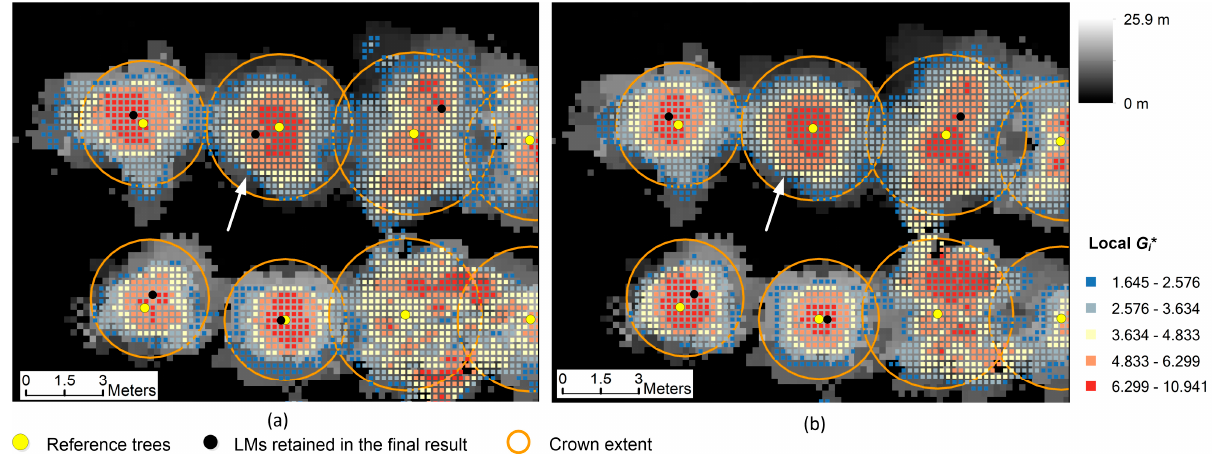
Figure 12. The effects caused by changing LM extraction-related parameter values on test site 2. The parameter values for each combination can be found in Table 3. MaxD = 1.5 m, significance level = 0.10, and score threshold = 9.